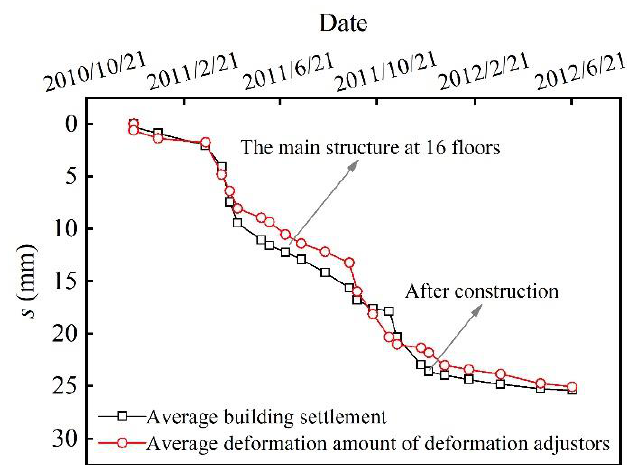
Figure 20. Comparison curve between average deformation amount and average building settle- ment